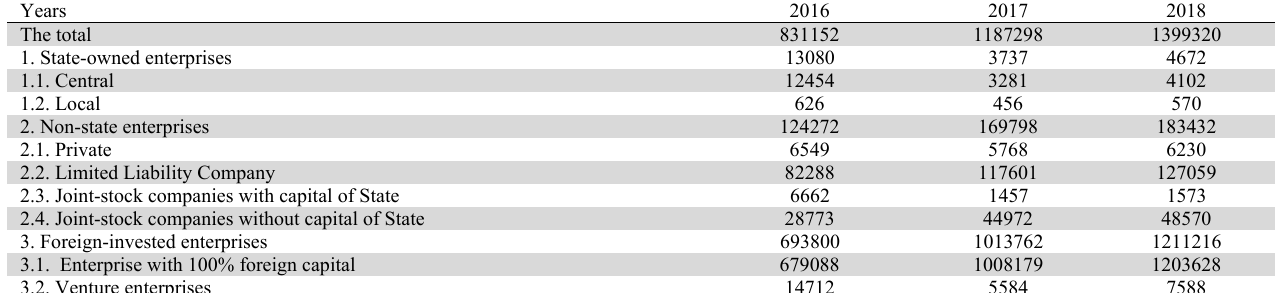
Net turnover of production and business activities of enterprises in Bac Ninh province (Unit: VND